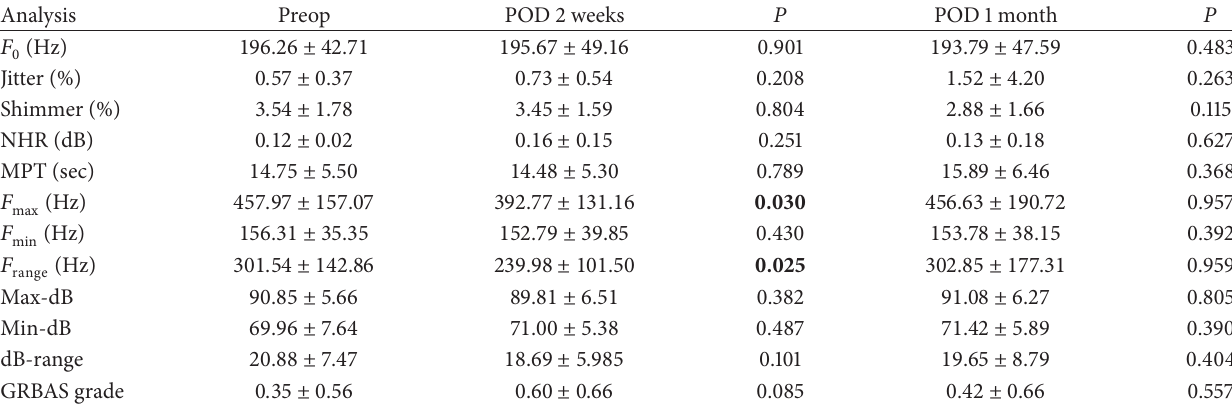
Table 2: Comparison of preoperative and postoperative outcomes of various vocal analysis in group